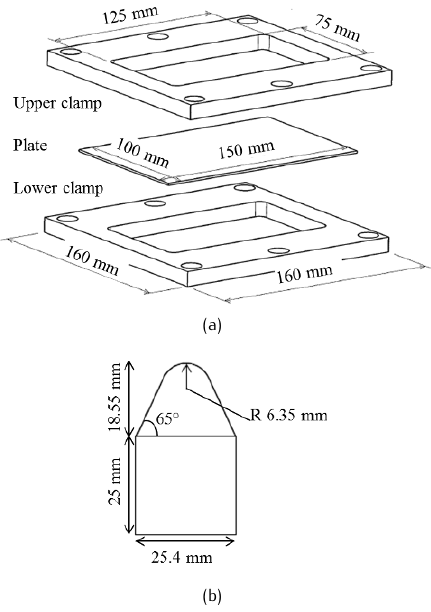
Figure 1. a) Test fixture and b) profile of the impactor nose.